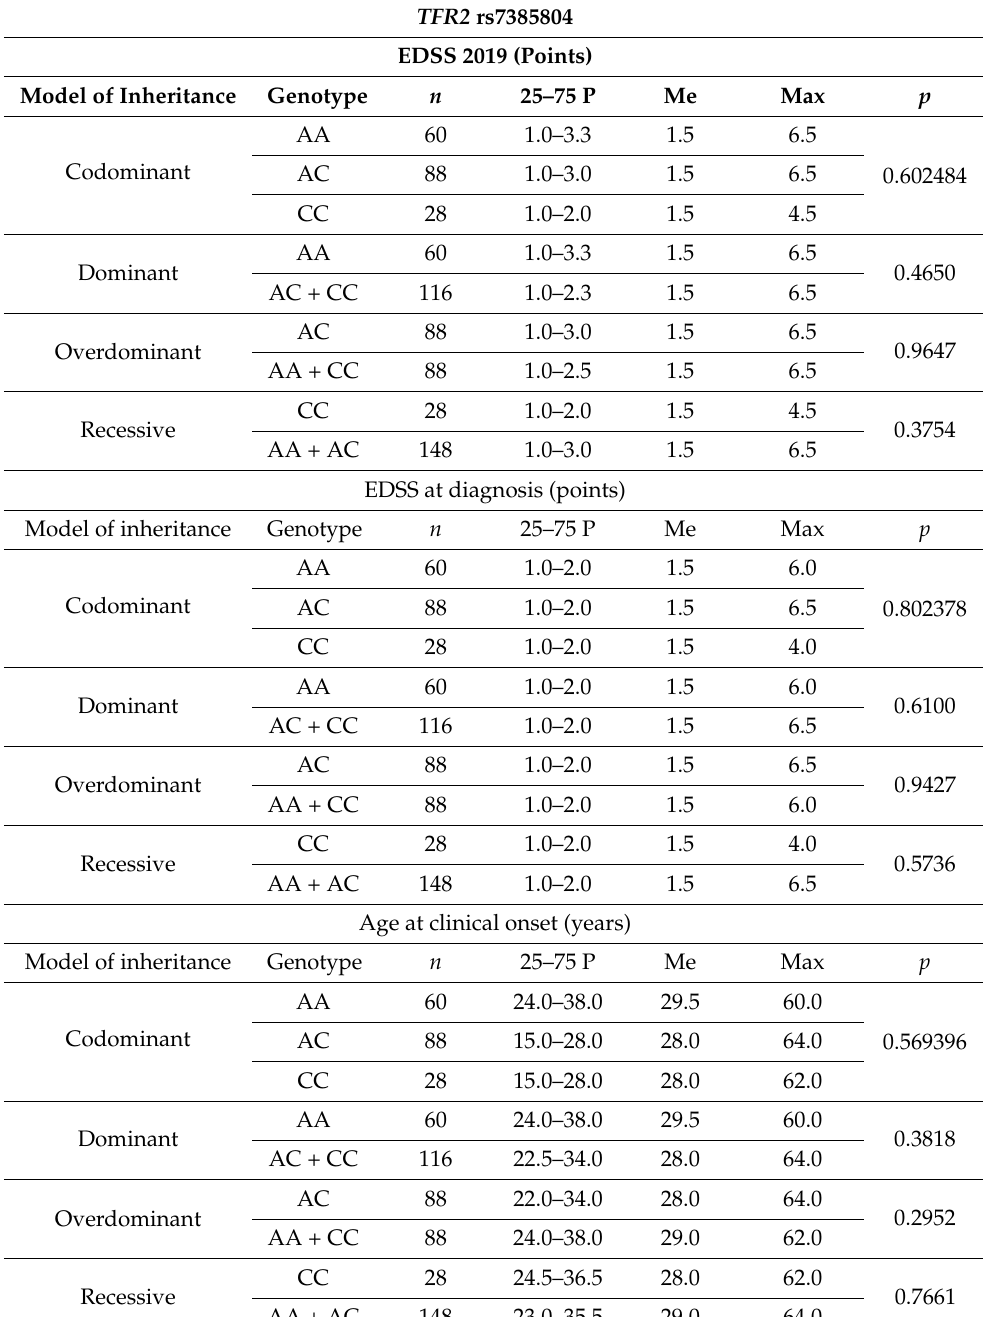
Table 6. Analysis of the relationship between the rs7385804 TFR2 polymorphism and selected clinical parameters. TFR2